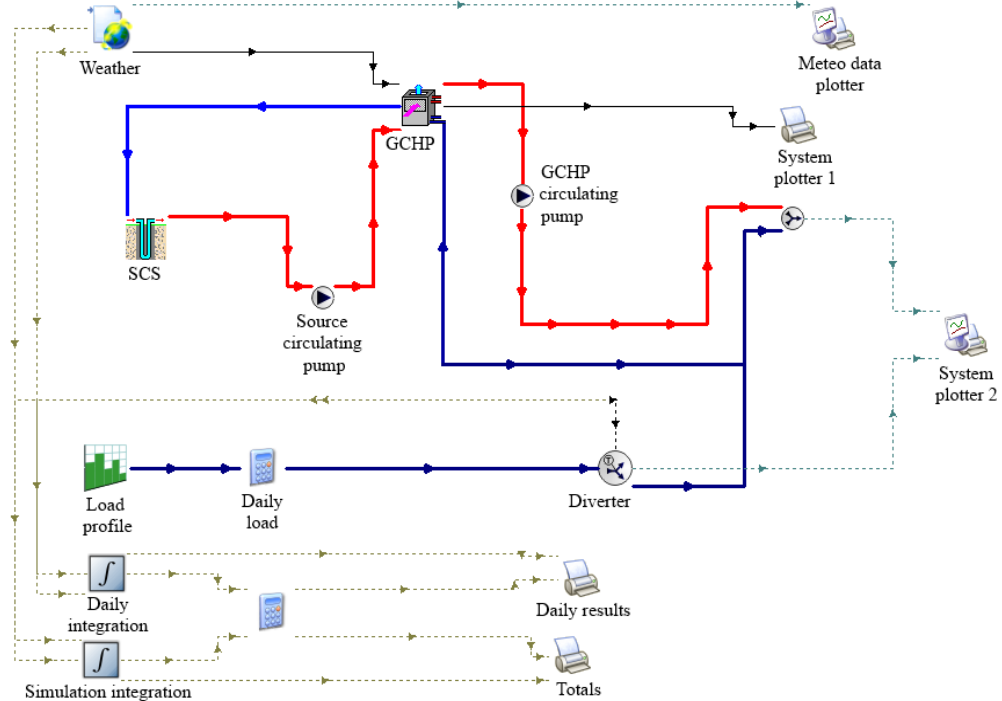
Figure 11. Schematic of the system model built in TRNSYS for COP simulation.